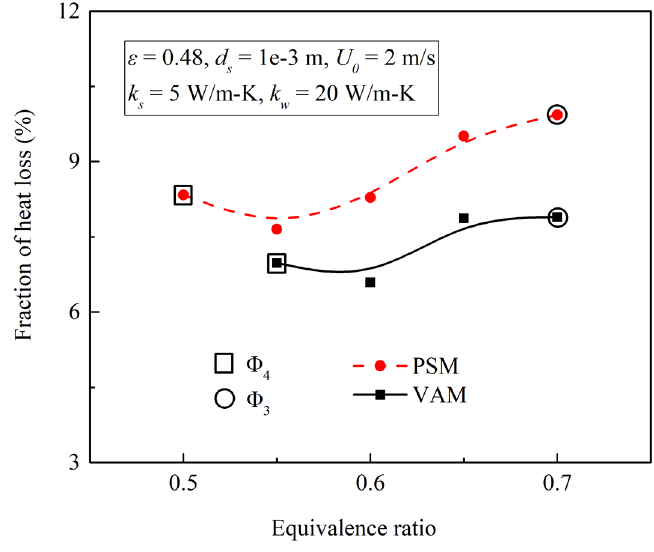
Figure 9. Fraction of heat loss obtained by the PSM and VAM.